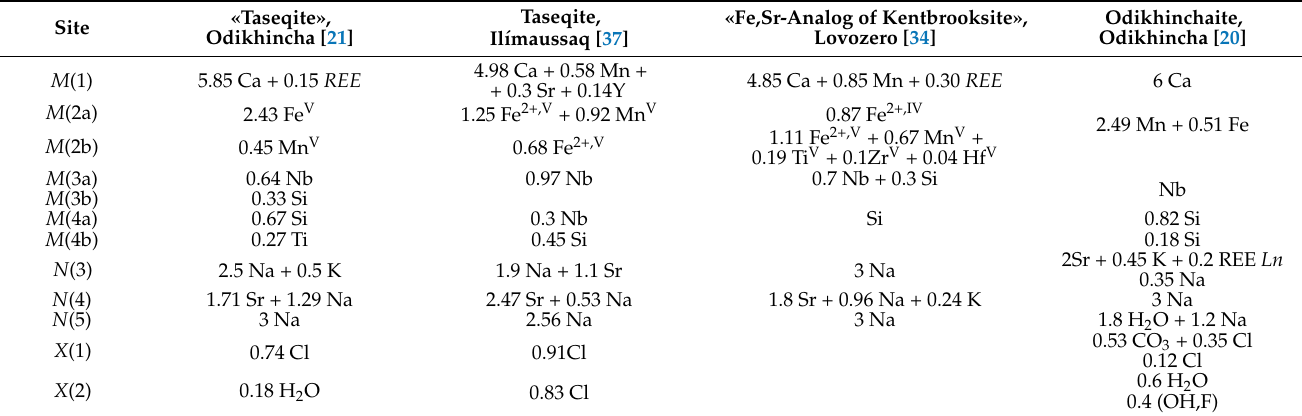
Table 6. Site populations (apfu) in the key positions of taseqite and taseqite-like